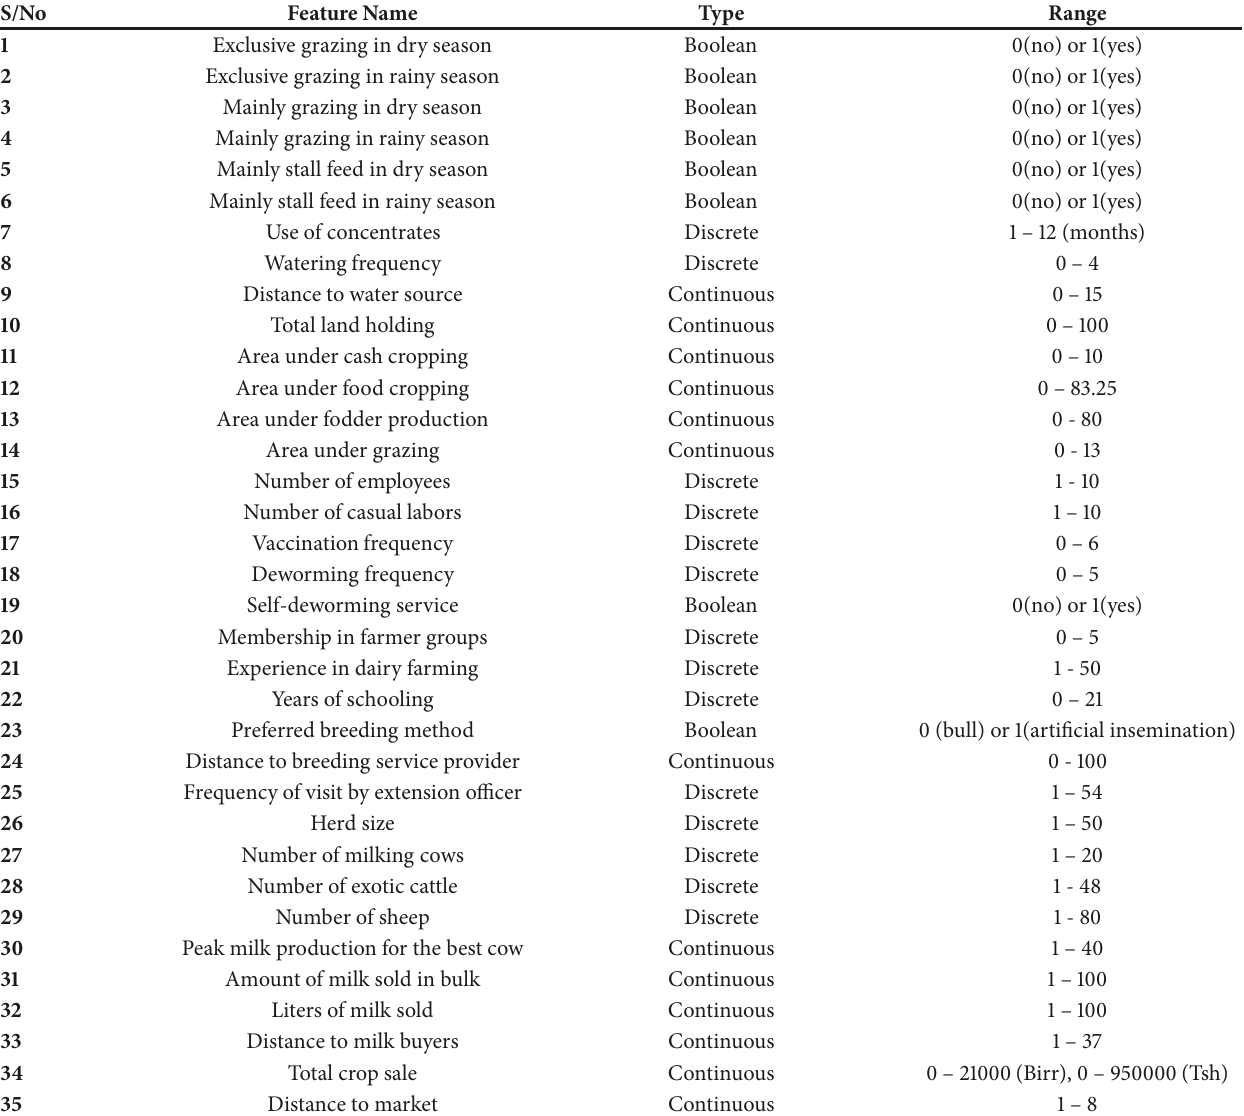
Table 1: Features used in cluster